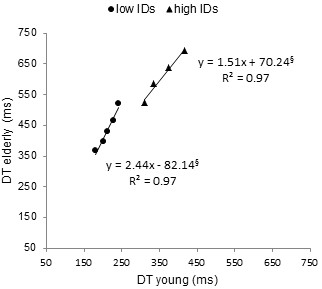
Brinley plots for DTs observed at lower and higher ID ranges. Mean DT data, linear fittings and their corresponding equations are presented for low (circles) and high (triangle) ID ranges. The “§”marked coefficients were not significant at 5%. The slope of the Brinley function quantifying age related slowing is greater for lower than for higher IDs.